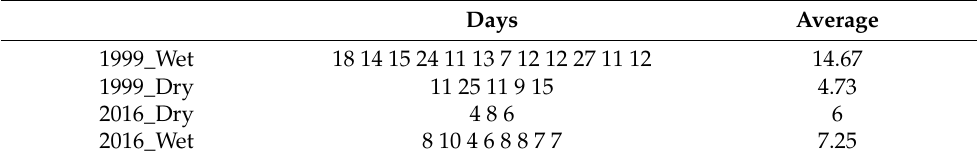
Figure 8. ( a – h ) Trends in heatwave mean intensity in CDHWs vs. non-drought periods (CDHWs/heatwaves during non-drought periods). Table 1. Number and average days of discrete heatwaves in dry and wet